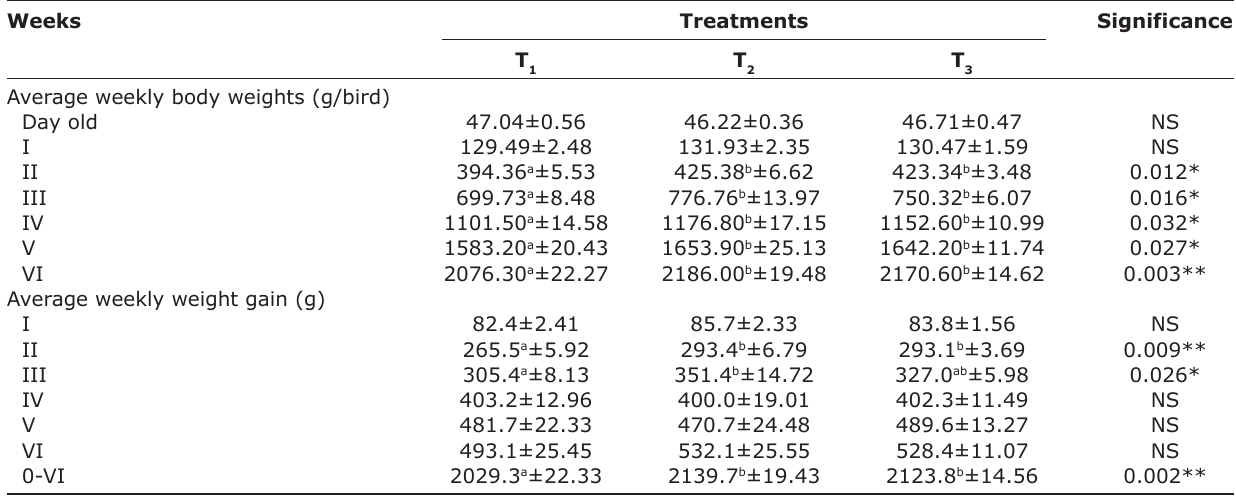
Table-2: Average weekly body weights (g/bird) and body weight gain (g) of broiler chicks under different treatment groups. Weeks